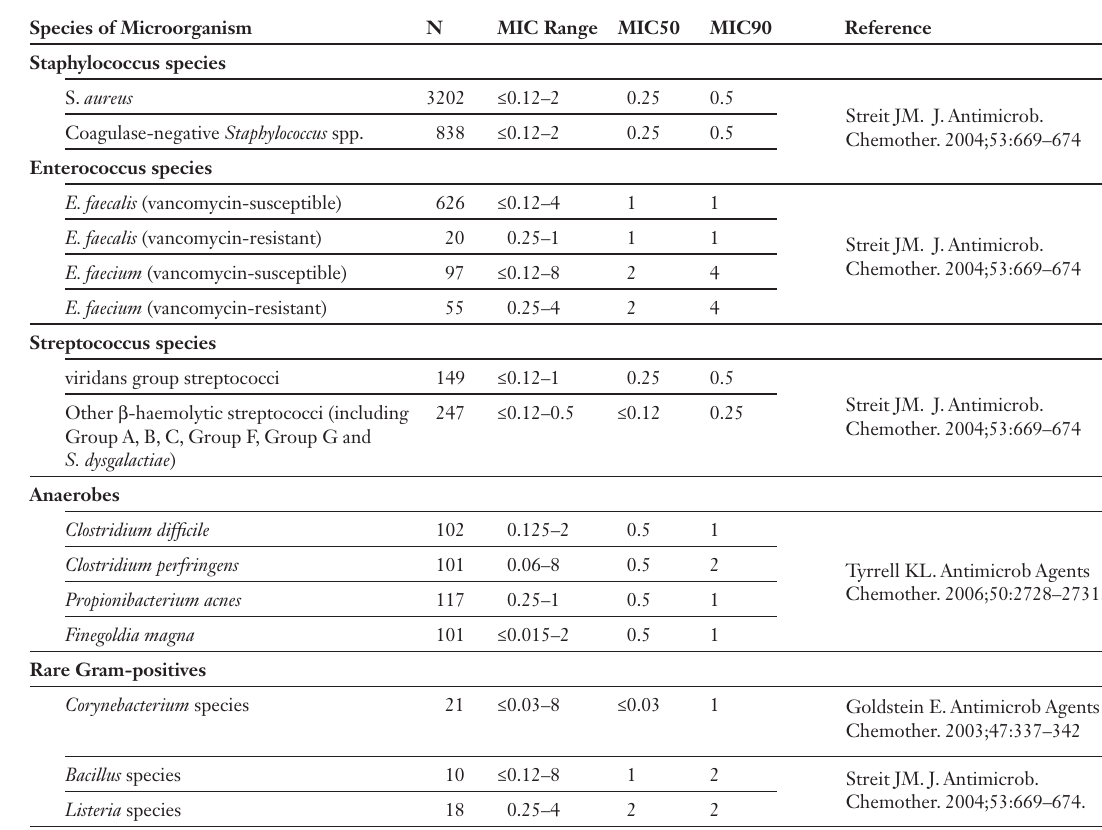
Table 1 In vitro activity of daptomycin against gram- positive